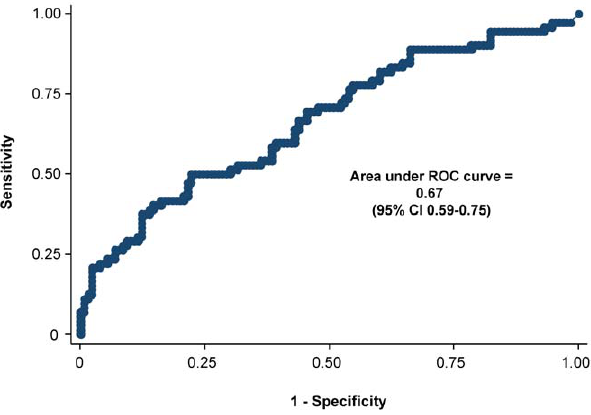
Figure 2. Receiver operating characteristic (ROC) curve. The sensitivity versus one minus the specificity of the cross-validated multivariable logistic regression model for diagnosing tuberculosis developed in this study is plotted at every threshold of probability of tuberculosis predicted by the model.